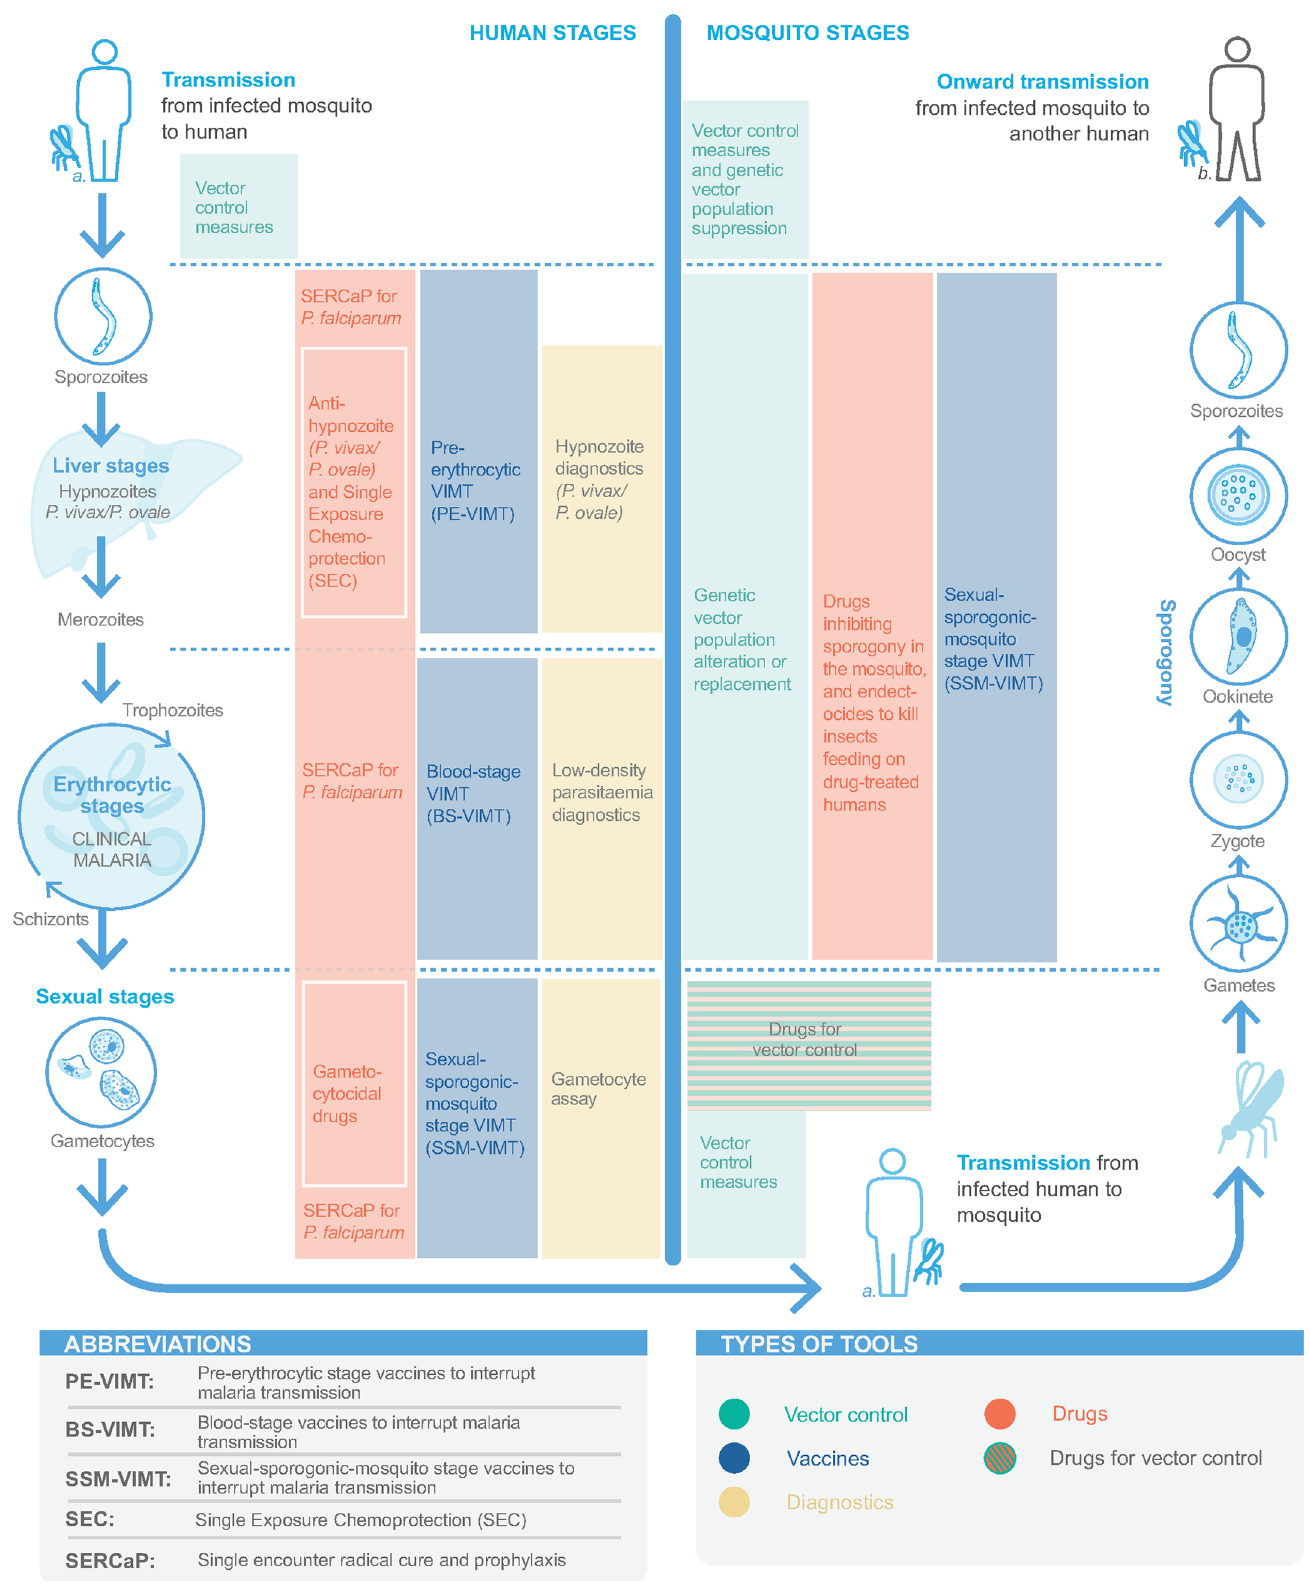
Fig 1. Tools for detecting and interrupting malaria transmission and their action in the malaria transmission cycle.